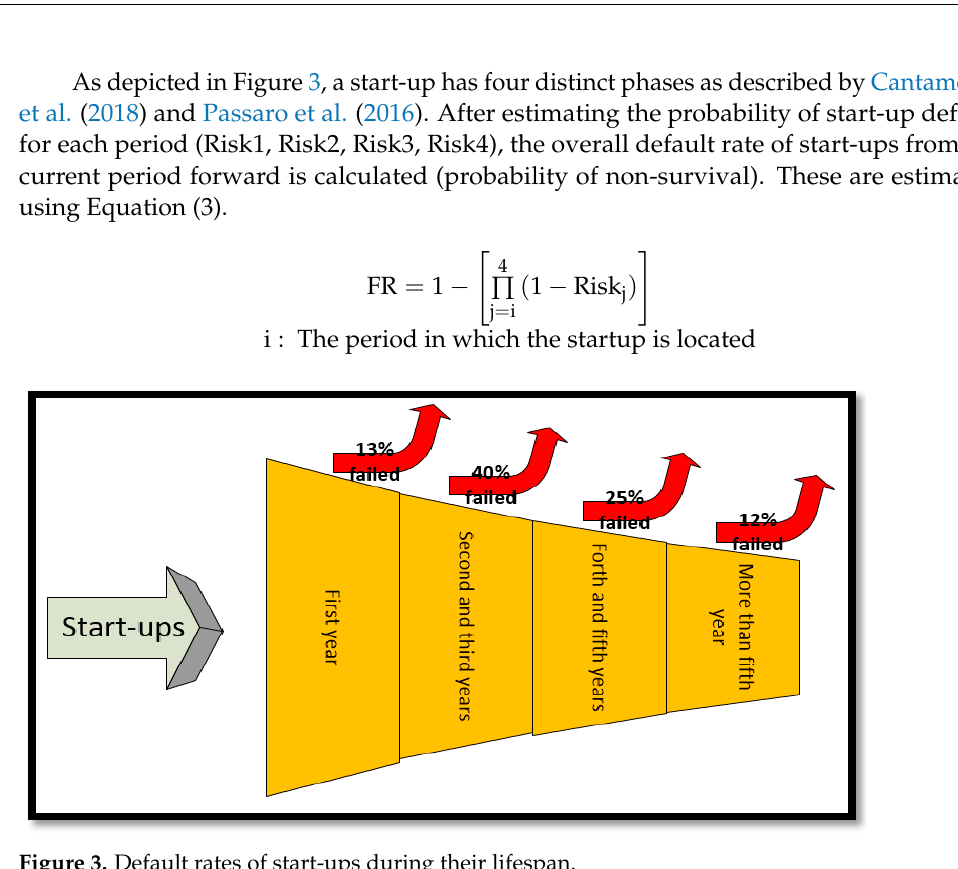
Figure 3. Default rates of start-ups during their lifespan